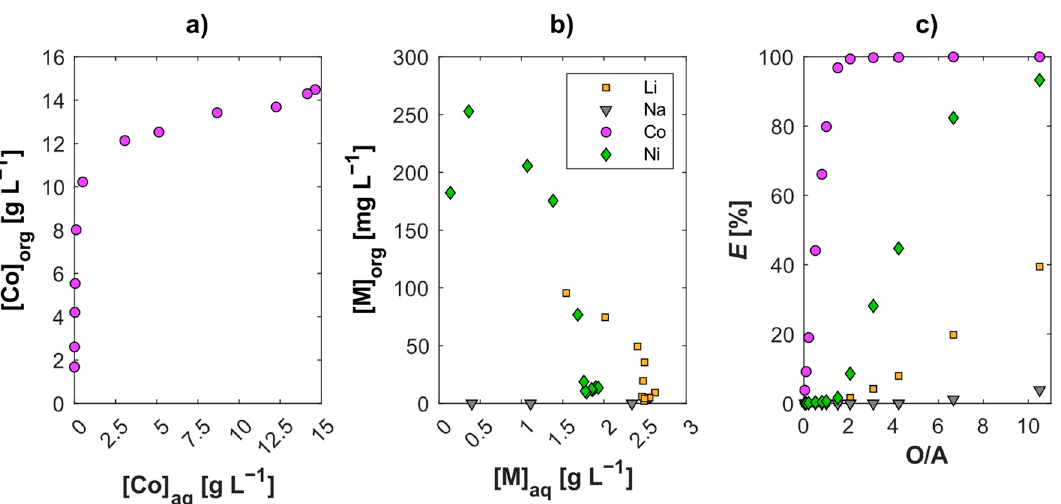
Figure 7. Distribution of Li, Ni, Co, and Na between 0.8 M Cyanex 272 (diluted in Exxsol D80) and Mn-free simulated LIB leachate: ( a ) Concentrations of cobalt in equilibrium; ( b ) Concentrations of Li, Ni, and Na in equilibrium; ( c ) Effect of O/A ratio on percentages of metals extracted. T = 25 ± 1 °C; pH = 5.3; t eq = 15 min. Initial aqueous concentrations [g L − 1 ]: Li: 2.70; Ni: 1.91; Co: 15.2. Co was concentrated to over 100 g L − 1 by stripping loaded Cyanex 272 with 2 M H 2 SO 4